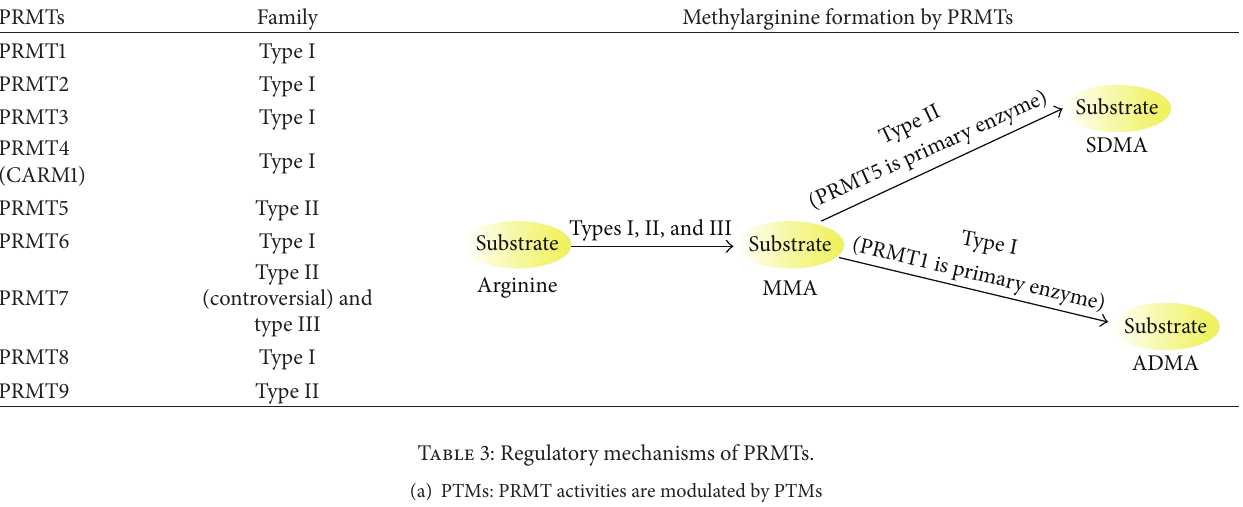
Table 2: Classification of the PRMT family.